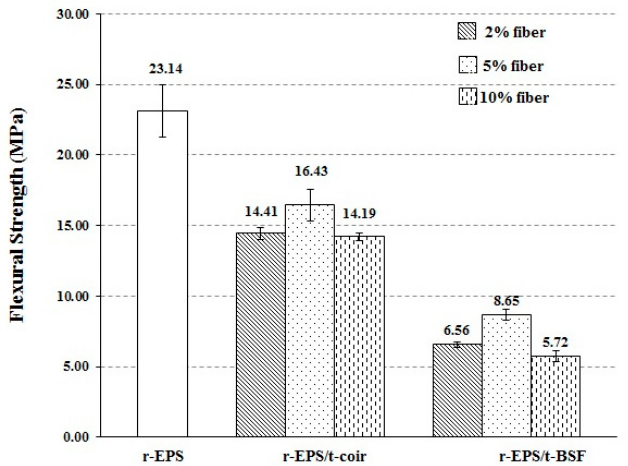
Figure 7. Flexural strength of r-EPS composites with treated BSF or coir at 2%, 5%, or 10% wt. fiber loadings.